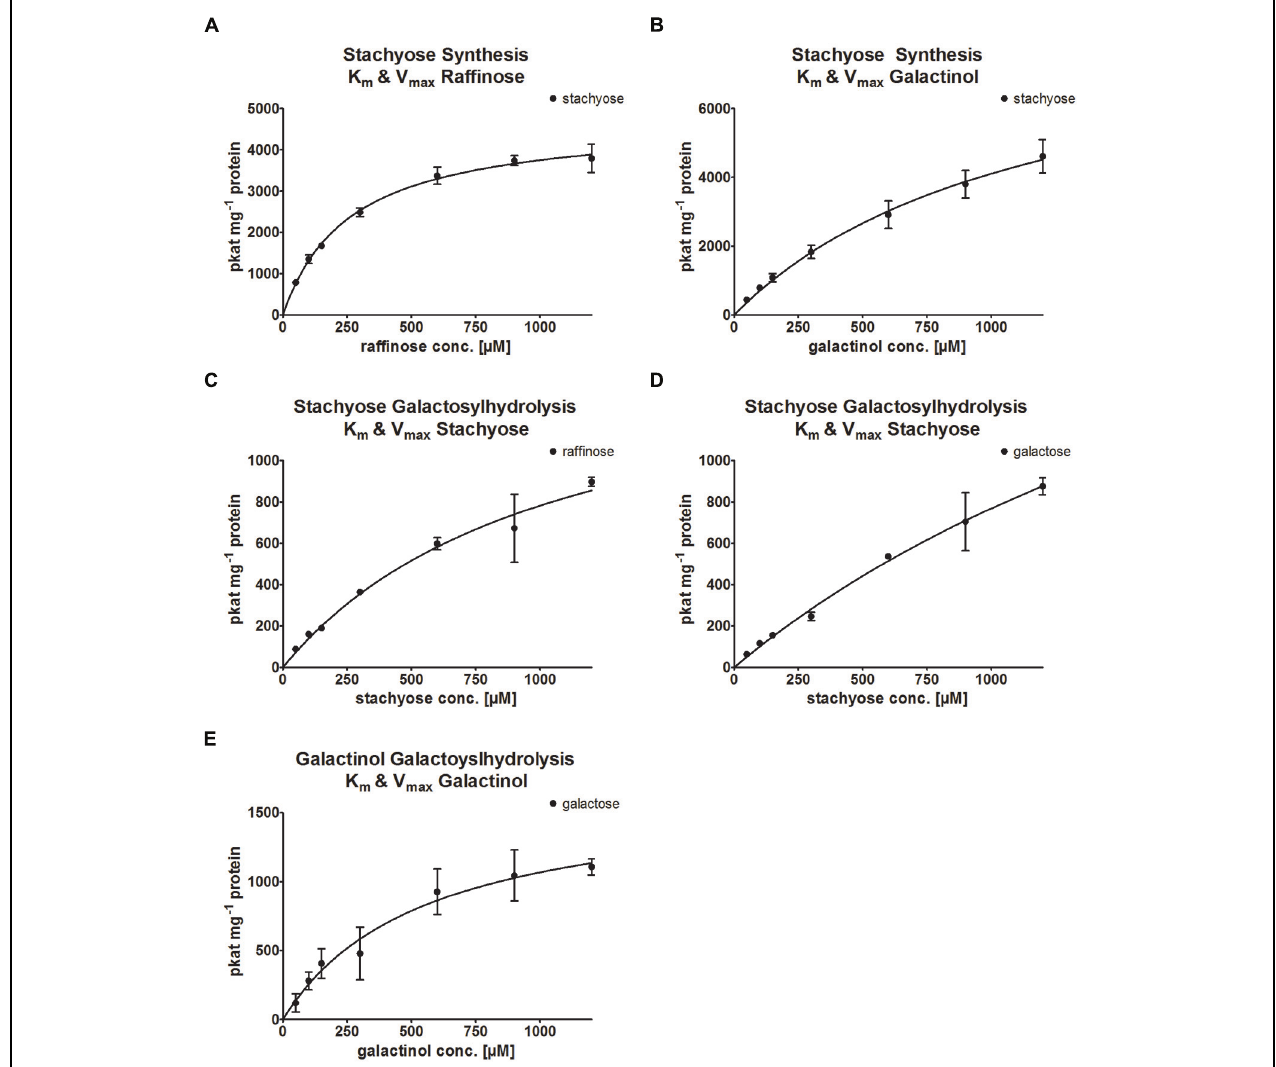
FIGURE 8 | Enzyme kinetics of recombinant AtRS4. Enzyme activity of recombinant AtRS4 was measured with varying concentrations of substrates (50 to 1,200 μ M) under standard conditions for 60 min with HPAEC-PAD enzyme assays. Values are averages of three independently performed assays ( ± SD ). (A) Substrate saturation by Michaelis–Menten curve for Raf is shown. K m with 259.2 ± 21.15 μ M and V max 4,722 ± 132.3 pkat mg − 1 protein was calculated. (B) Substrate saturation by Michaelis–Menten curve for Gol is shown. K m with 1,170 ± 246.8 μ M and V max with 8,911 ± 1,105 pkat mg − 1 protein was calculated. (C) Substrate saturation by Michaelis–Menten curve for Sta measuring Raf is shown. K m with 1,059 ± 269,3 μ M and V max 1,610 ± 233,3 pkat mg − 1 protein was calculated. (D) Substrate saturation by Michaelis–Menten curve for Sta measuring Gal is shown. K m with 2,832 ± 1,043 μ M and V max 2,944 ± 820.4 pkat mg −